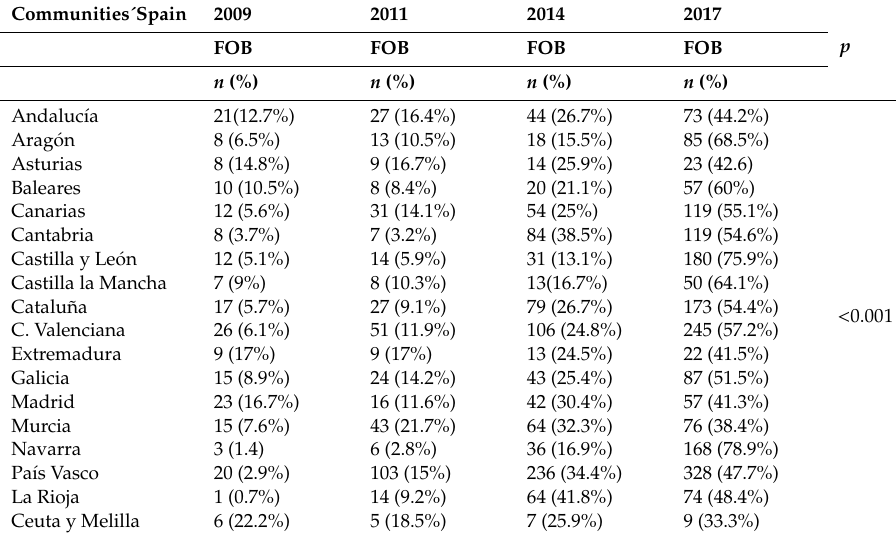
Table 3. Fecal occult blood testing of Spanish people between 50–70 years (n = 27,821) in the period 2009–2017 in the Communities’ Spain.